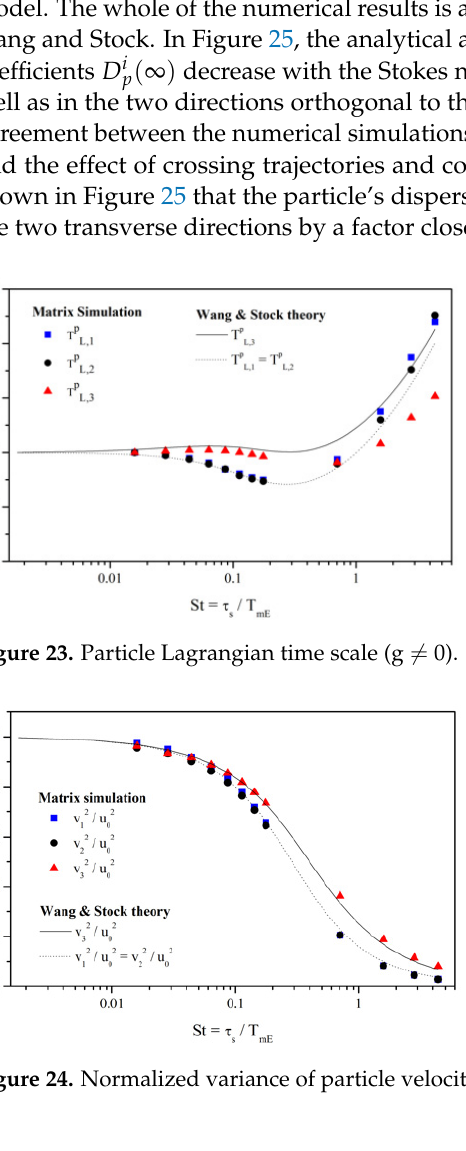
Figure 22. Particle dispersion coefficient (g = 0).